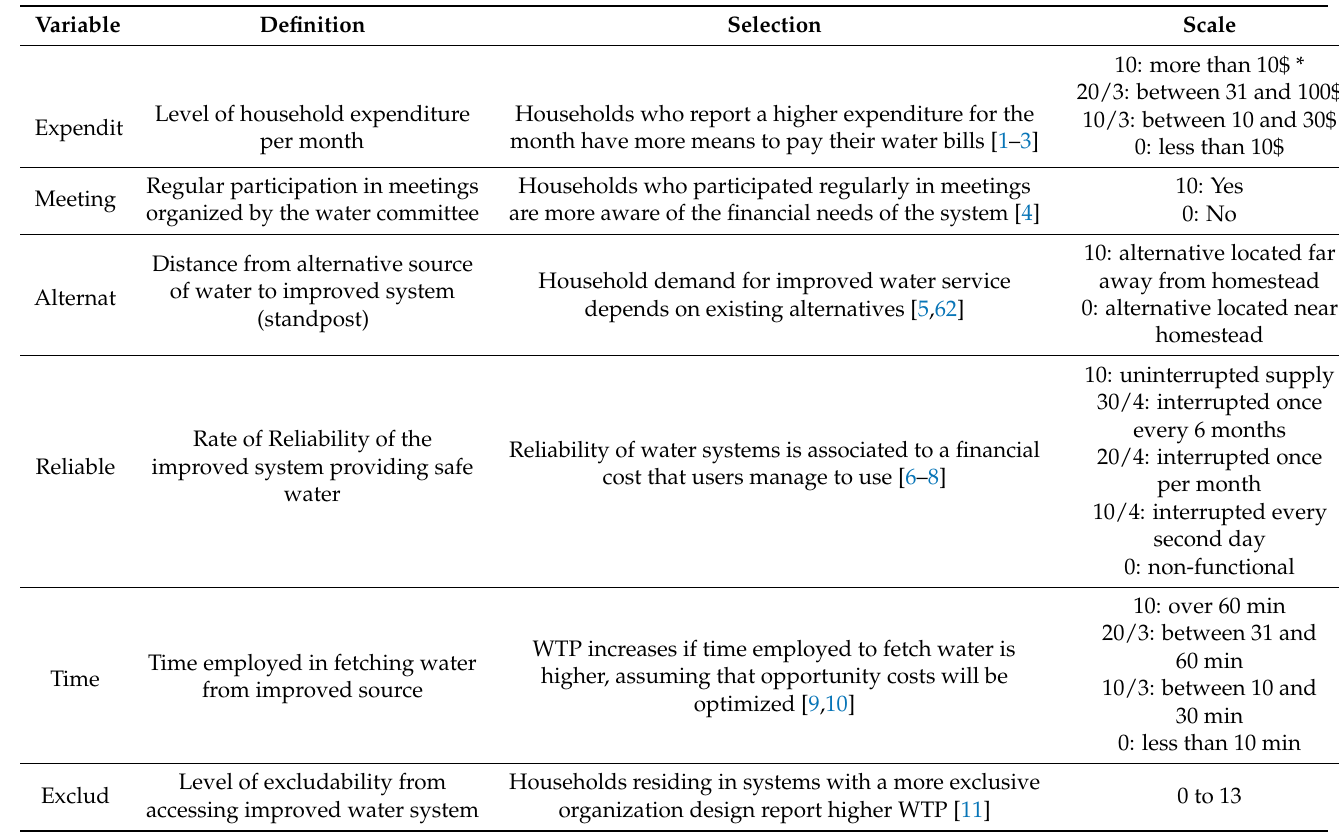
Table 2. Independent variables definition, selection and